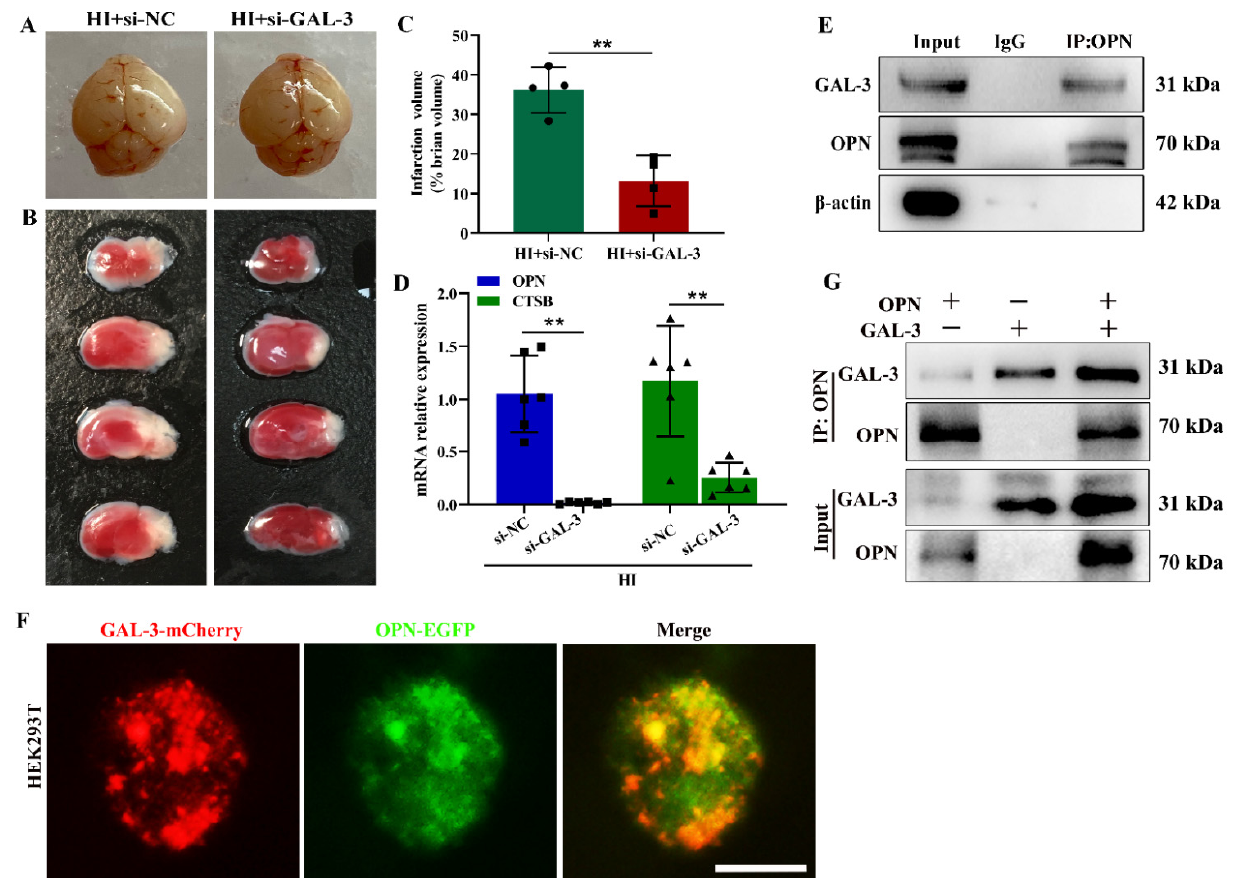
Figure 5. OPN interacted with GAL-3 in microglia/macrophages following HI exposure. ( A ) Repre- sentative images of brains at 3 d following HI treated with si-GAL-3 or si-NC ( n = 4). ( B , C ) Repre- sentative TTC staining and quantification of brains infarct volumes at 3 d following HI treated with si-GAL-3 or si-NC ( n = 4). ( D ) OPN and CTSB mRNAs in the HI+si-NC or HI+si-GAL-3 group were detected by qRT-PCR ( n = 6). ( E ) Western blot showing co-IP of OPN with GAL-3 in BV-2 cells treated with OGD for 3 h. All experiments were performed three times. ( F ) Fluorescence analysis showed that OPN was colocalized with GAL-3 in HEK293T cells transfected with plasmids encoding OPN-EGFP together with GAL-3-mCherry ( n = 6). ( G ) Co-IP assays of OPN interacting with GAL-3 in vitro. All experiments were performed three times. Scale bar = 20 µm. Values represent the mean ± SD, ** p < 0.01 according to the t -test in ( C , D ). co-IP, co-immunoprecipitation CTSB, cathepsin B; GAL-3, galectin-3; HI, hypoxia–ischemia; NC, negative control; OPN, osteopontin.